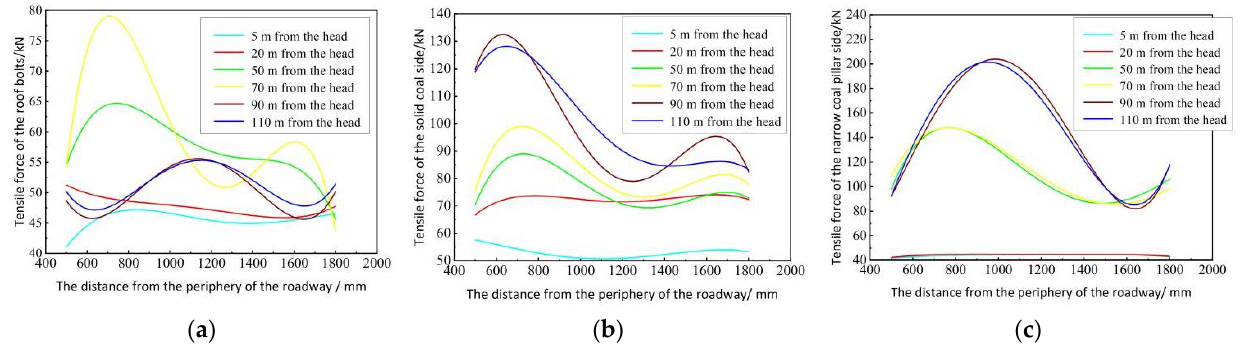
Figure 15. The stress of the bolt in different positions from the head of the tunnel face. ( a ) The roof bolts on the roadway, ( b ) the bolts on the solid coal side, and ( c ) the bolts on the narrow coal pillar side.